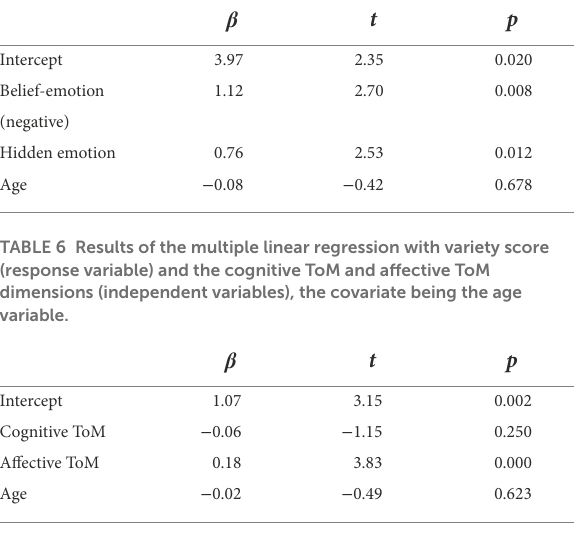
TABLE 5 Results of the multiple linear regression with persuasion total score (response variable), affective ToM tasks (predictor variables), and the age variable as a covariate.